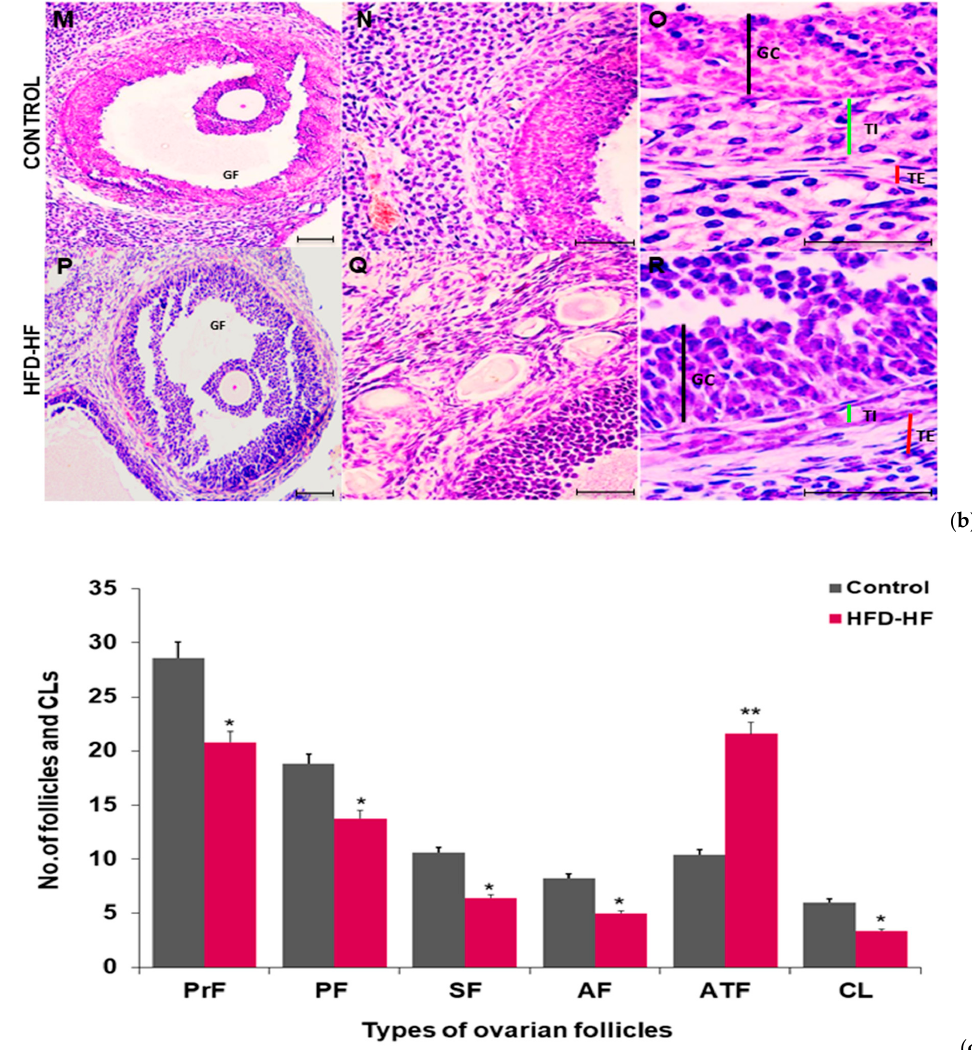
Figure 3. The representative photomicrographs of the ovary of control adult rats exhibiting normal histoarchitecture with clear primordial follicles, primary follicles, secondary follicles, antral follicles, and preovulatory and ovulatory follicles, along with corpus luteum (( a ) A – J ). A compact arrangement of granulosa cells (GCs) and theca cells (TCs) with a clear demarcation line in the ovary of control rats (( a ) A – C , G – I ;( b ) M – O ) is visible, whereas the ovary of the adult rats subjected to HFD-HF diet showing disturbed histoarchitecture with a thin layer of TCs and disintegrated GCs, a few fresh corpora lutea, a large number of follicular cysts and atretic follicles (( a ) D – F , J – L ; ( b ) P – R ). (Scale bar = 100 µ m) ( c ) A histogram represents the numbers of counted follicles and corpora lutea in the ovary of rats fed on the HFD-HF diet, compared to the control. Abbreviation: CL: corpora lutea; TC: thecal cells, GC: granulosa cells, C: follicular cysts; TI; Theca interna layer; TE: Theca externa, PrF: primordial follicles, PF: primary follicle, SF: secondary follicles, AF: antral follicles, ATF: atretic follicle. Each bar is the mean ± SEM of three observations from six animals of each group. The (*, **) signs noted on the bars represent statistically significant differences between the respective means (* p ≤ 0.05, ** p ≤ 0.01 vs. control